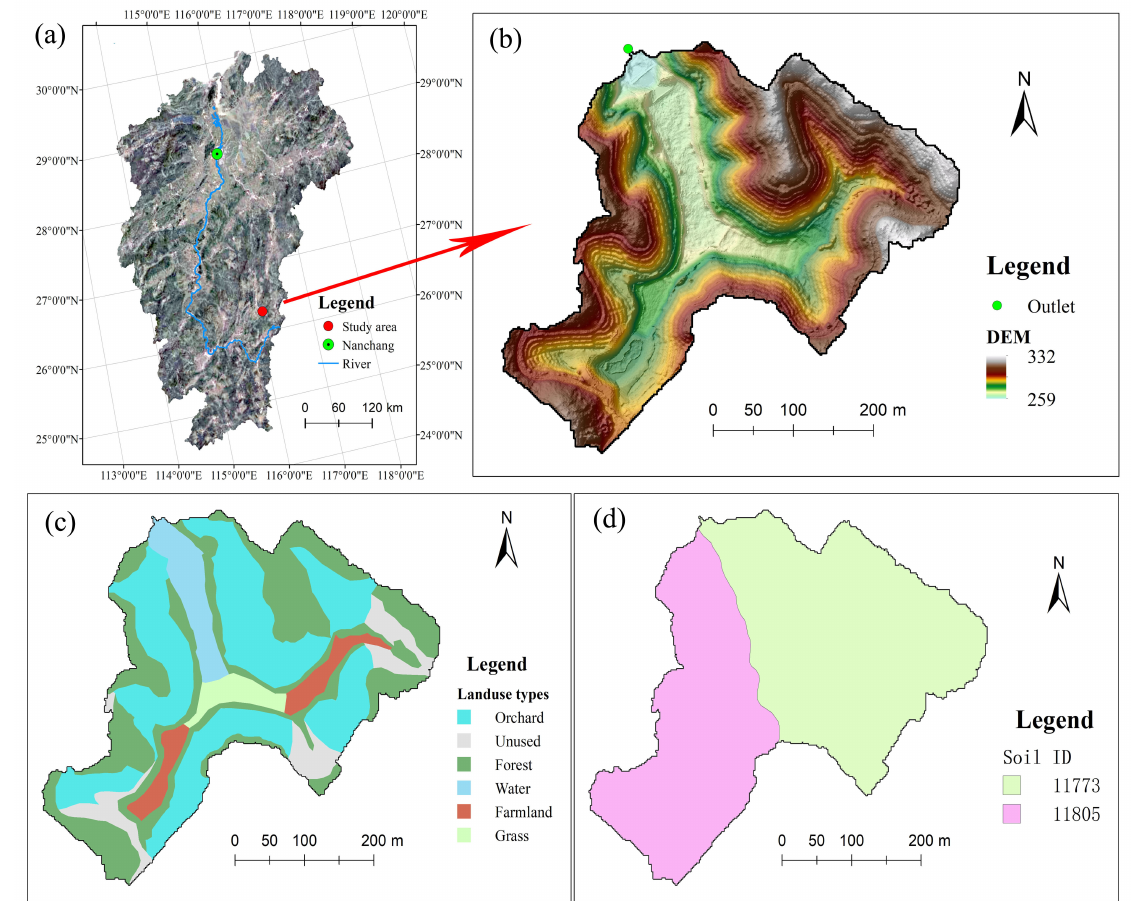
Figure 1. The location of the study area and maps of DEM, land use, and soil types. ( a ) The location of the study area, in Jiangxi Province, China. ( b ) The DEM of the study area. ( c ) The land-use types of the study area. ( d ) The soil types of the study area.